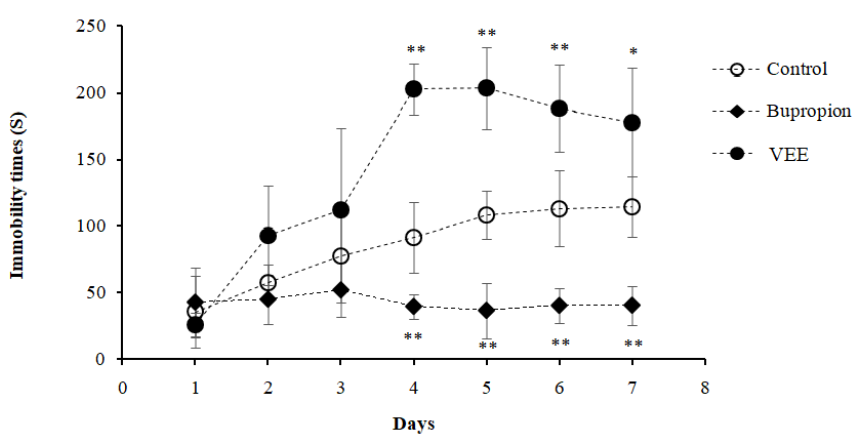
Figure 2. E ff ect of the oral administration of VEE (100 mg / Kg) and bupropion (20 mg / Kg) on mice Figure 2. Effect of the oral administration of VEE (100 mg/Kg) and bupropion (20 mg/Kg) on mice immobility times in tail suspension test compared to the control (water 10 mL / Kg, p.o.). Results were immobility times in tail suspension test compared to the control (water 10 mL/Kg, p.o.). Results were expressed in mean of immobility time ± SD. * P < 0.05; ** P < 0.001 compared with Control expressed in mean of immobility time ± SD.* P < 0.05; ** P < 0.001 compared with Control group.